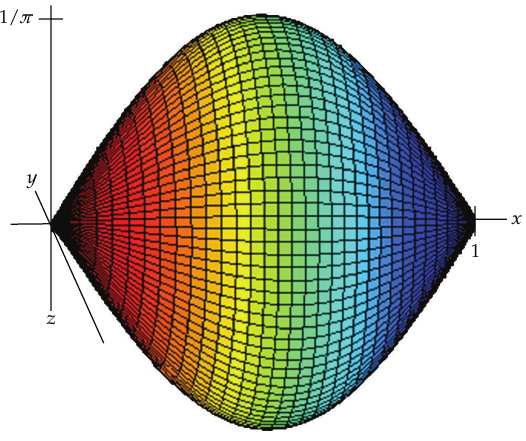
Figure 4: B (cid:2) b (cid:3) —Example